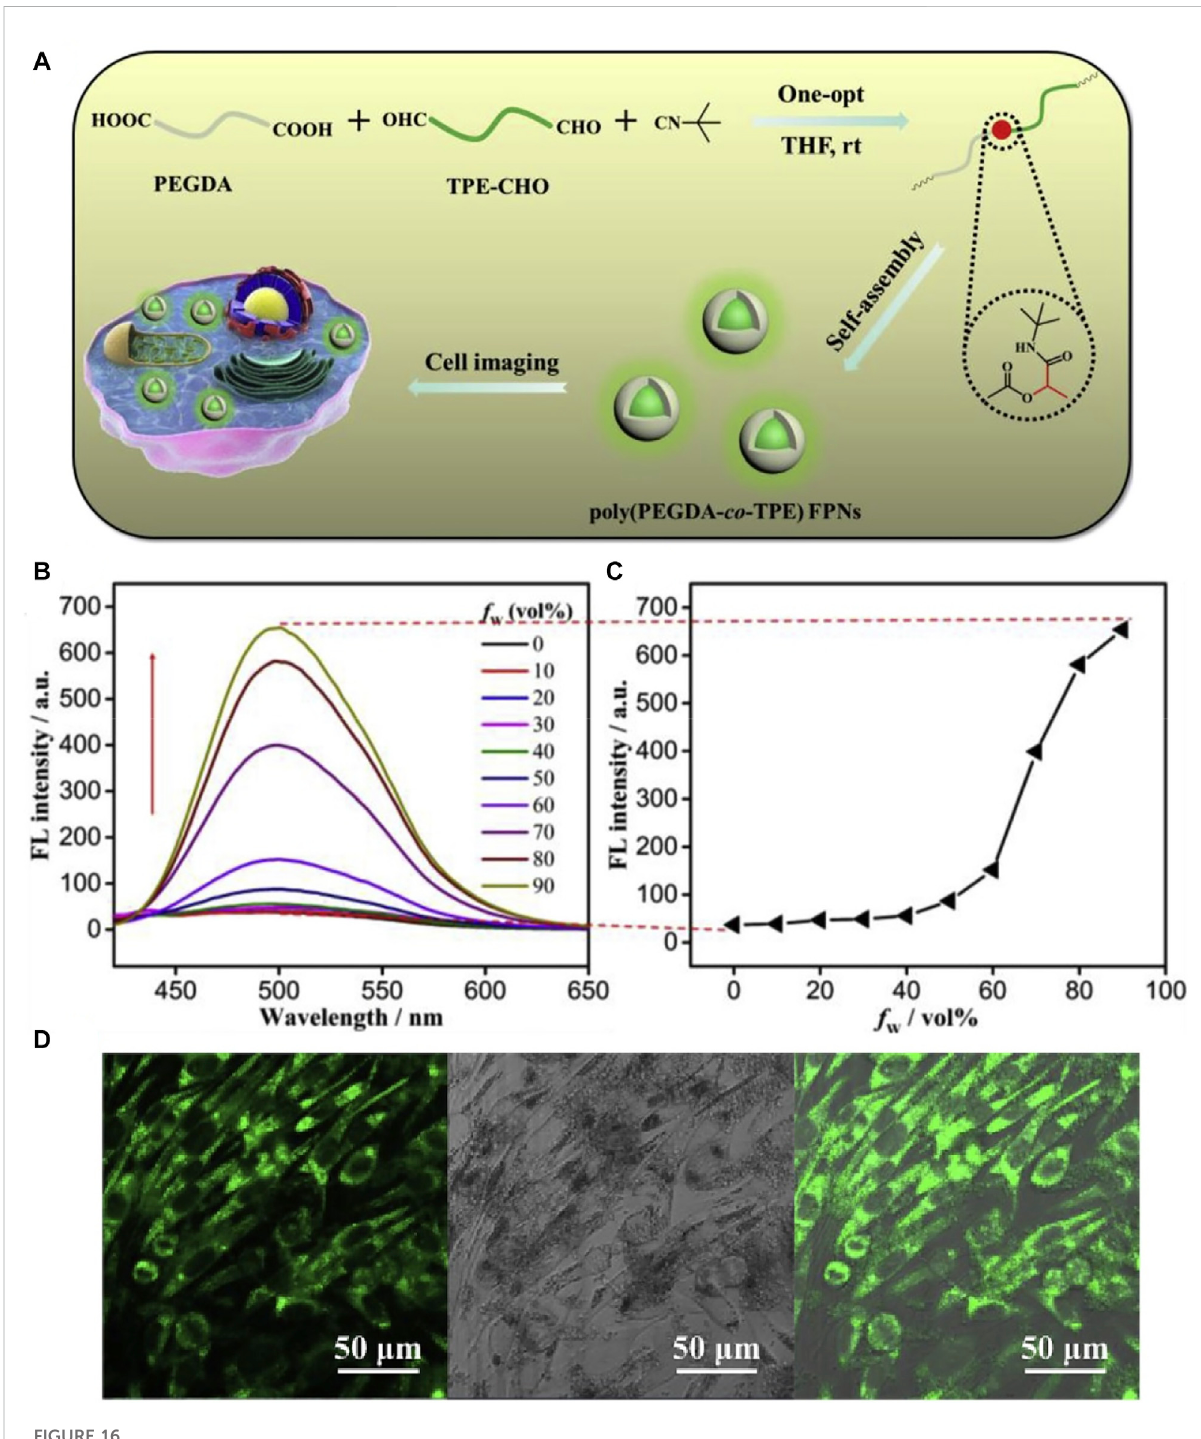
FIGURE 16 (A) Schematic showing the preparation of poly (PEGDA-co-TPE) FPNs for cell imaging; (B) the fl uorescent spectra of poly (PEGDA-co-TPE) in DMF/water mixtures with different water fractions; (C) the relationship of fl uorescent spectra of poly (PEGDA-co-TPE) versus water fraction in the mixed solution; and (D) CLSM images of L929 cells incubated with 40 μ g ml − 1 of poly (PEGDAco-TPE) FPNs (Jiang R. et al.,